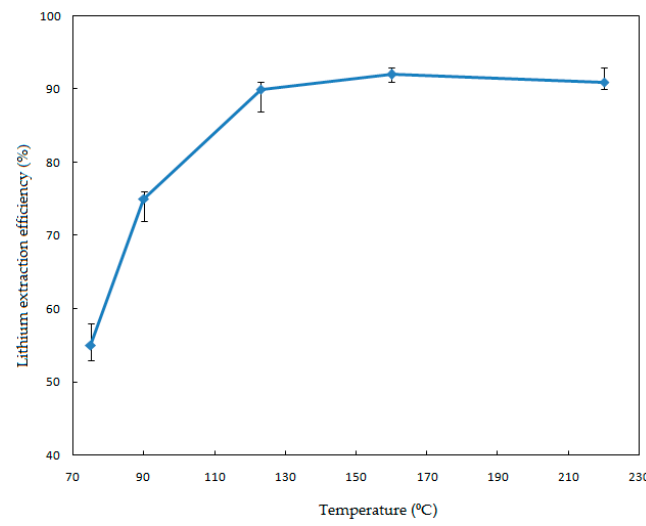
Figure 3. Effect of the temperature on the Li extraction efficiency.